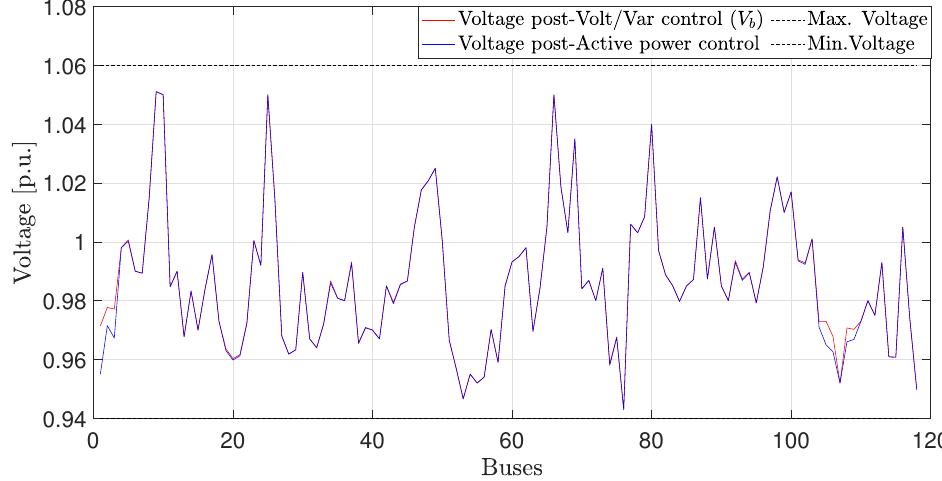
Figure 10. Results of the Volt/Var control − Voltage profile.